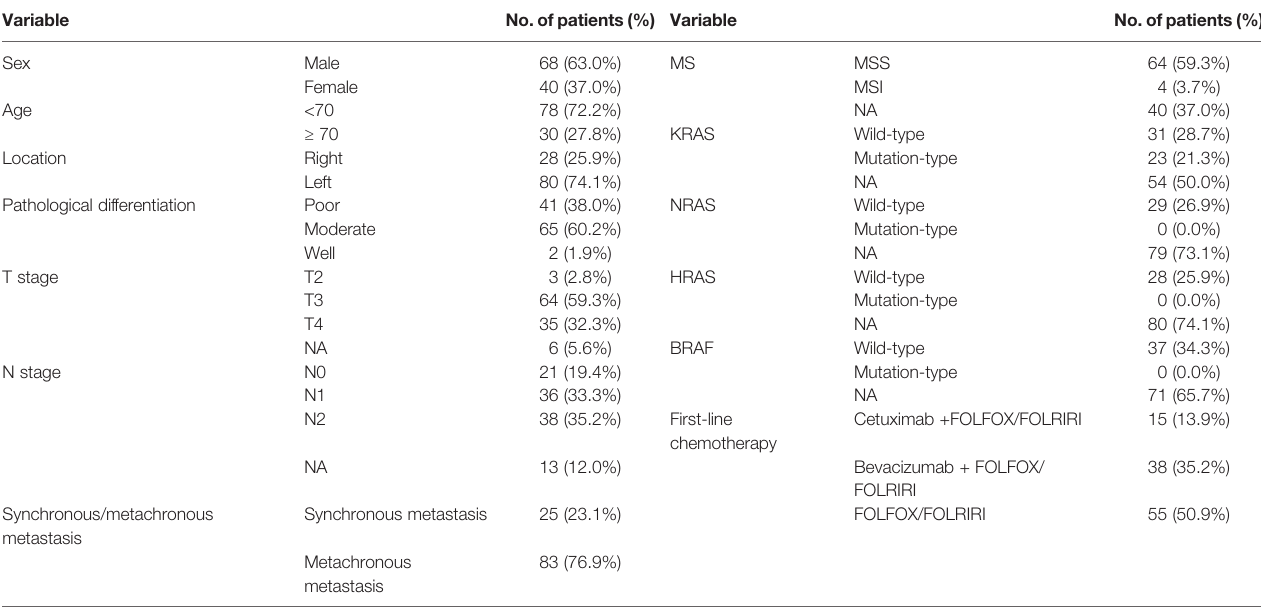
TABLE 1 | Basic clinicopathological molecular characteristics of 108 metastasis colorectal cancer patients.